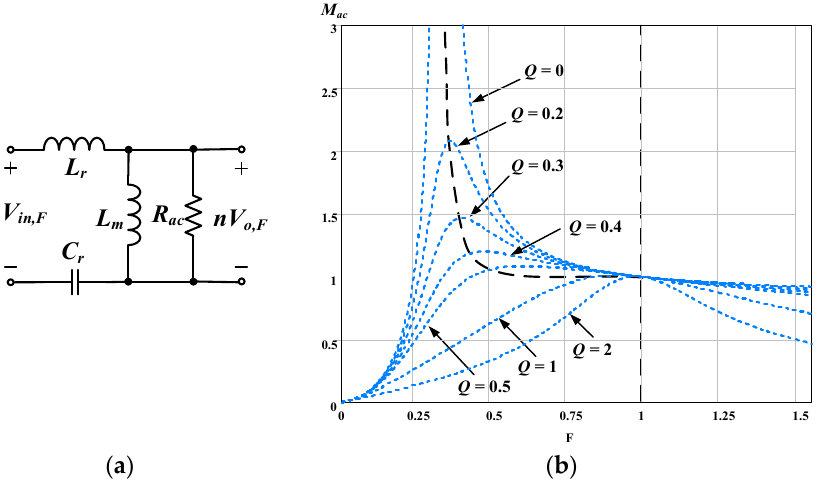
Figure 3. Resoant tank of resonant converter: ( a ) equivalent circuit, ( b ) voltage gain. The disadvantages of the unidirectional DC converters for a battery charger are the required step-up and step-down circuits to ensure that more circuit components are